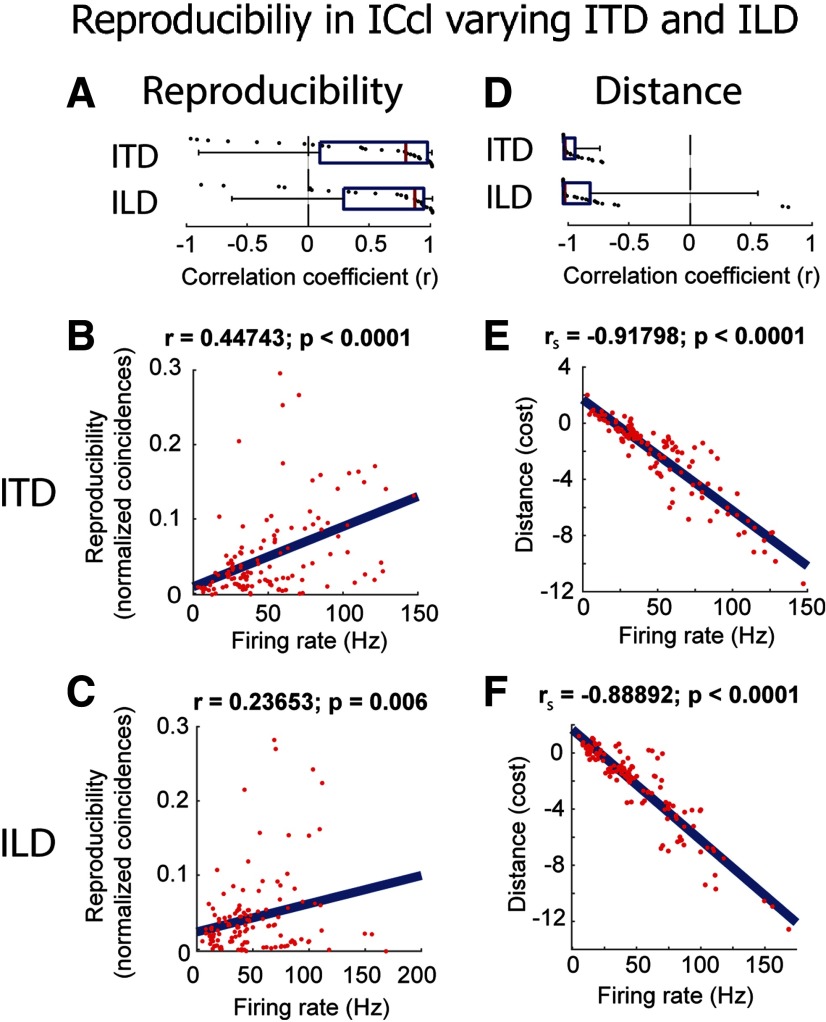
Relationship between reproducibility and firing rate of ICcl neurons (N = 33), varying binaural cues. A, Correlation coefficients (r) of reproducibility against firing rate in each neuron for varying ITD (top) and ILD (bottom). Red lines indicate the median, blue boxes represent the first and third quartile, and whiskers are the 5th and 95th percentiles. B, C, Reproducibility against firing rate for all neurons for varying ITD (B) and ILD (C). Red dots represent individual data points and blue lines are linear regressions. Correlation coefficients (r) and p values are shown above each plot. D–F, Same description as for A–C but for the corrected Victor–Purpura distance metric.